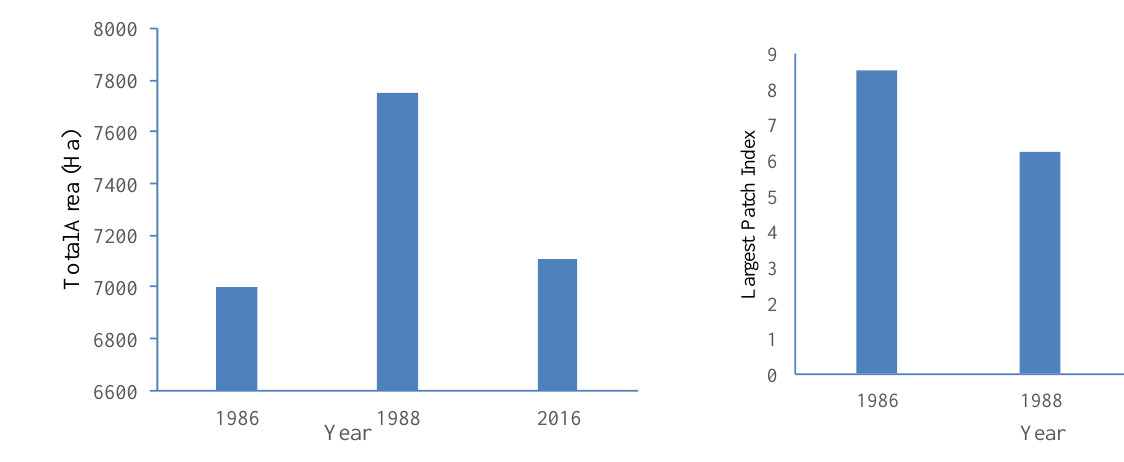
Figure 5. Total area (CA) changes in 1986, 1998 and 2016